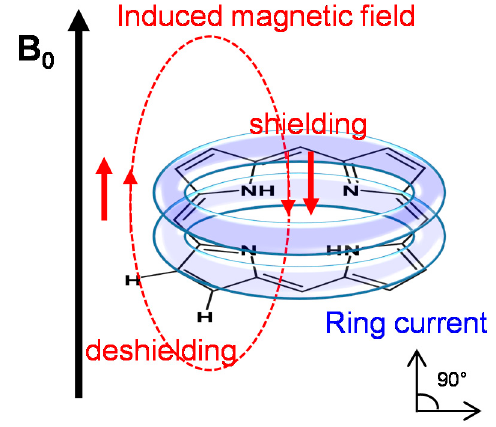
Figure 2. Scheme of porphyrin ring current.